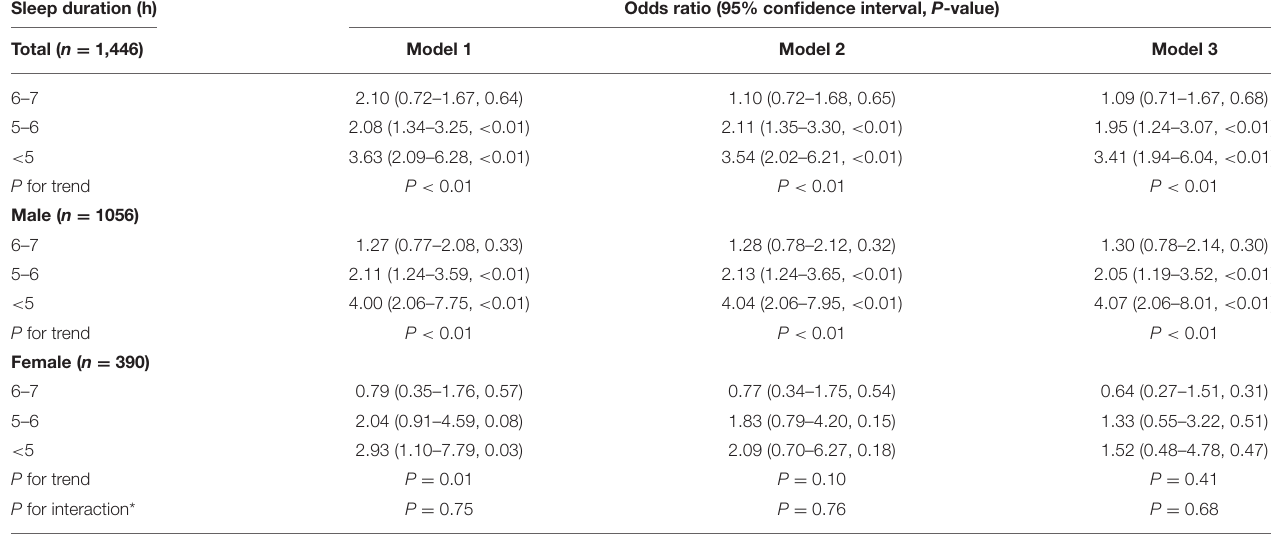
TABLE 2 | Impact of sleep duration on anxiety at 3 months after stroke.